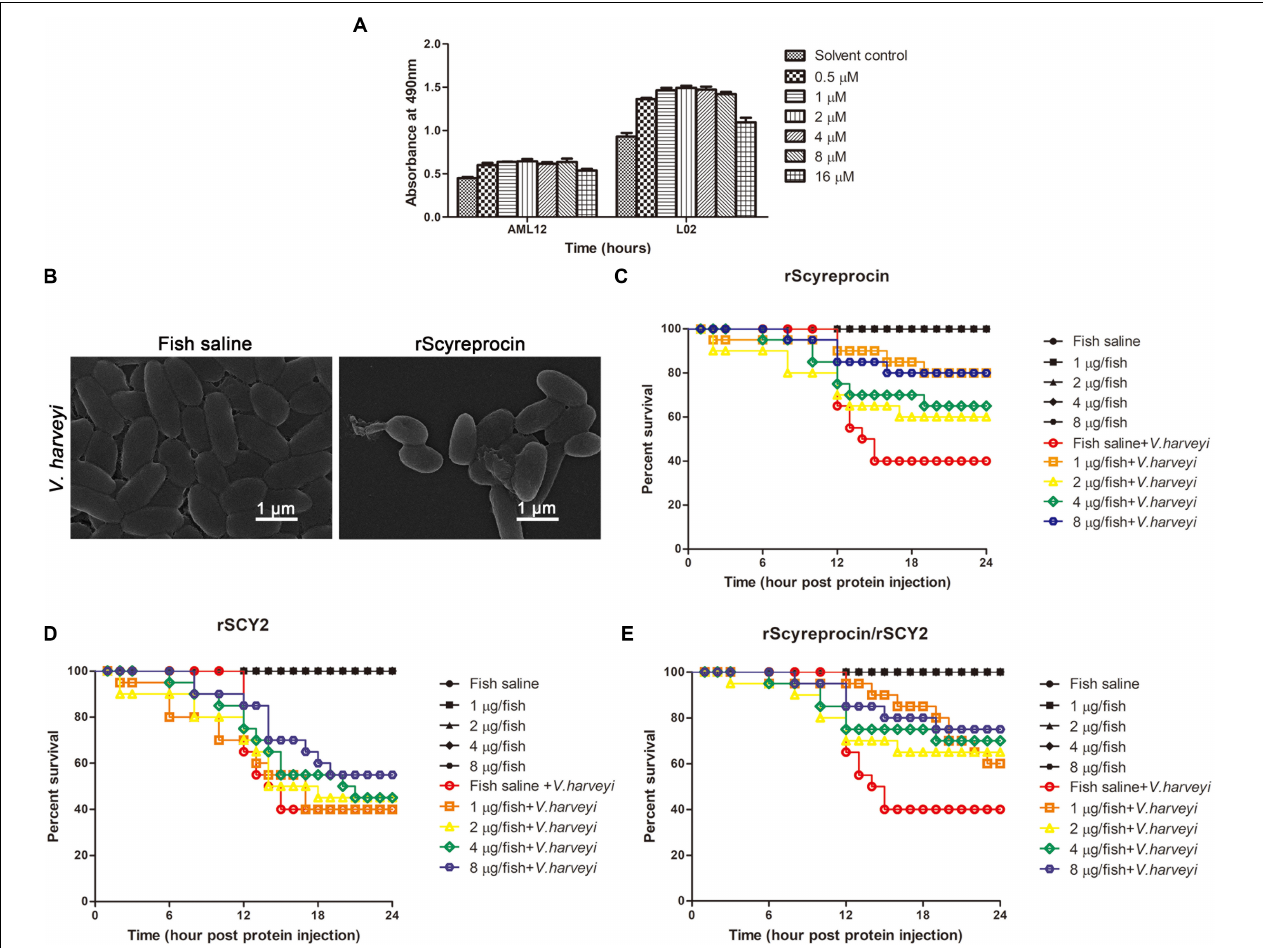
FIGURE 8 | In vivo protective effect of rScyreprocin, rSCY2, and rScyreprocin/rSCY2 on Vibrio harveyi -infected Oryzias melastigma . (A) Cytotoxicity effect of rScyreprocin on mammalian cells. Murine and human hepatic cells, AML12 and L02, were incubated with culture media supplemented with various concentrations of rScyreprocin, and cell viability was determined by MTS method. Data represent the means ± SEMs from three independent experiments. (B) Scanning electron microscopy images showing the effect of rScyreprocin on V. harveyi observed. (C–E) Fish were challenged with V. harveyi at semi-lethal dose, and injections of rScyreprocin (C) , rSCY2 (D) , and rScyreprocin/rSCY2 (E) at various dosages were given at 2-h post-bacterial challenge ( n = 20 for each group). The survival curve of each experimental group was analyzed using the Kaplan–Meier log-rank